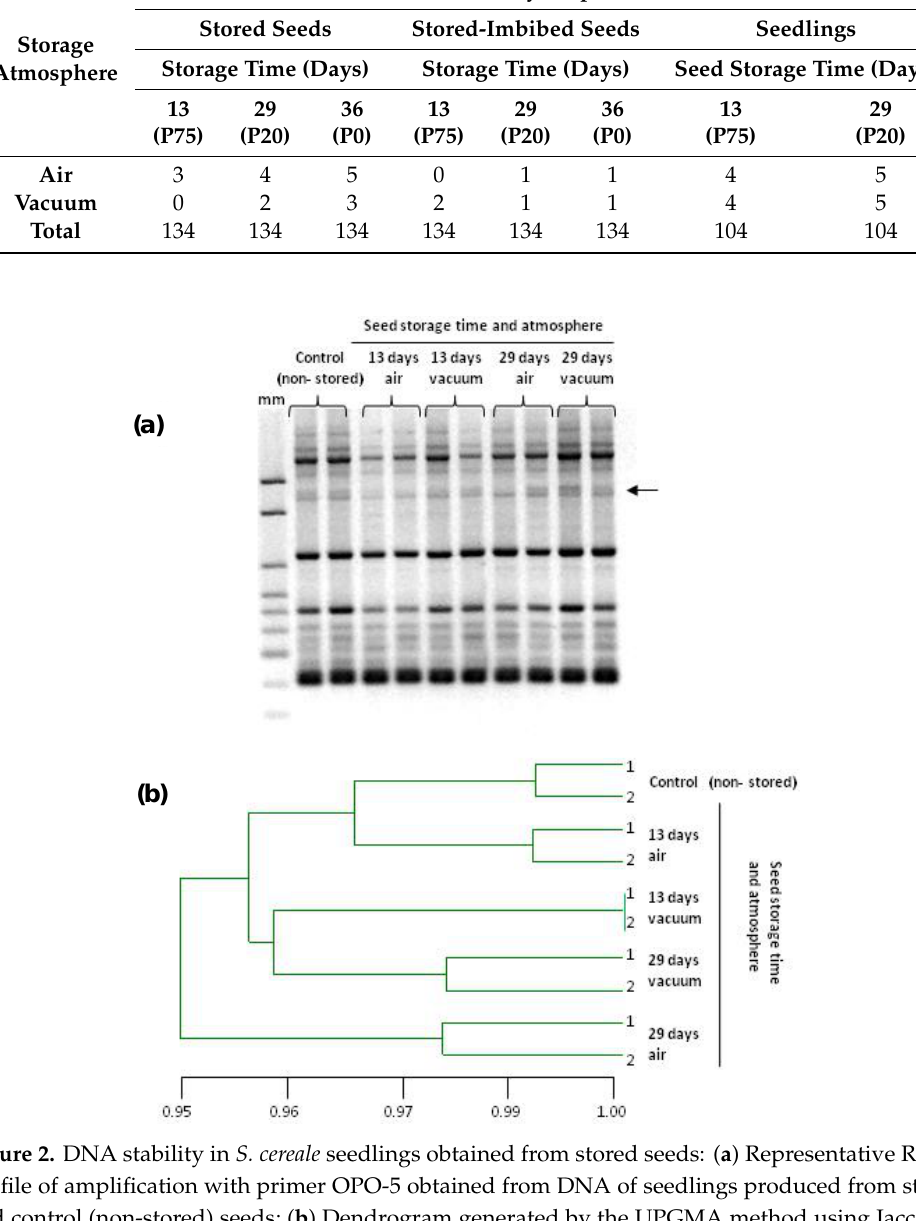
Table 2. Number of markers obtained from random amplified polymorphic DNA (RAPD) analysis of Secale cereale seeds (stored or stored-imbibed) and seedlings produced from them. Seeds were stored at 35 °C, 15% wc under two different storage atmospheres: air or vacuum. DNA was isolated from two replicates of 50 seeds or of 10 seedlings, per storage condition.